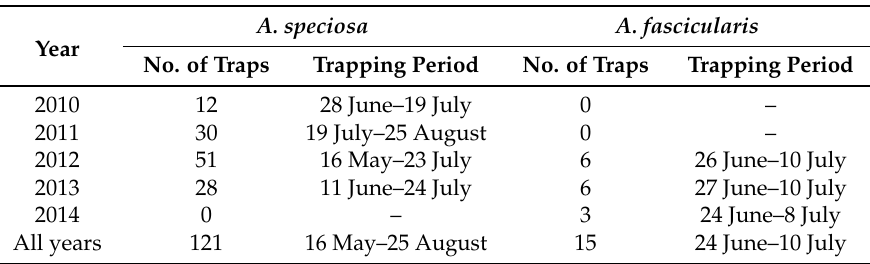
Table 2. Number of traps used and trapping period for A. speciosa and A. fascicularis during 2010–2014 in central Washington. A. speciosa A. fascicularis Year No. of Traps Trapping Period No. of Traps Trapping